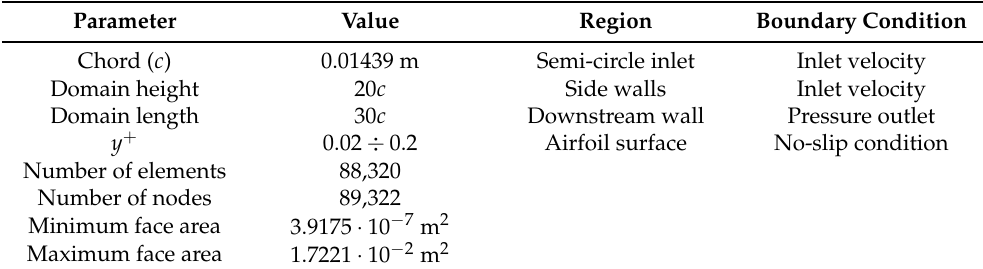
Table 1. Mesh properties and boundary conditions. The viscous scaled wall distance range ( y + = yu τ / ν ) is intended for the range of Reynolds numbers achievable on the airfoil surface during the experimental tests, that is Re = 4000 ÷ 70,000, based on the mean chord.